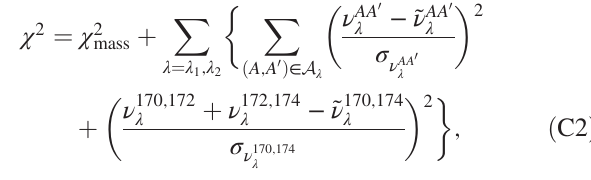
and τ correspond to the detuning of the PA A A and T correspond to the number of the A A